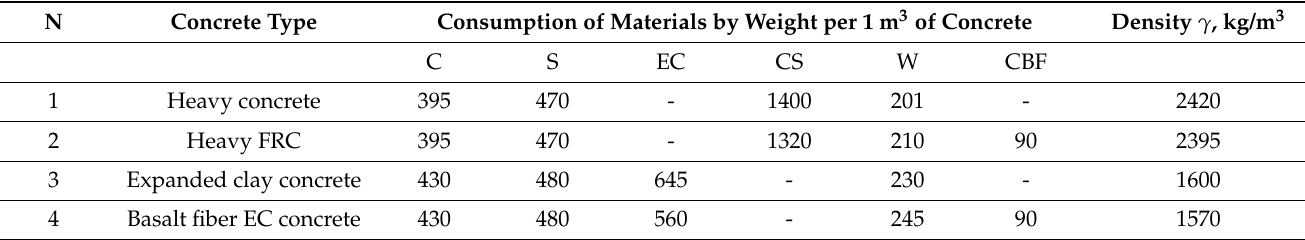
Table 5. Materials consumption for the heavy and light FRC preparation with a strength of 25